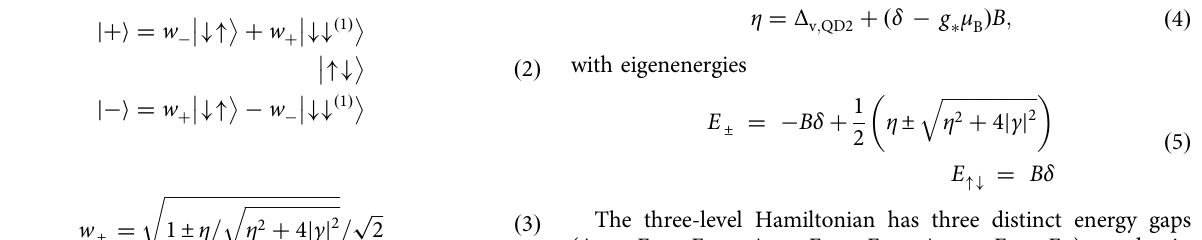
Fig. 2 Spin-valley driven singlet – triplet rotations. a Schematic of the pulse sequence used to interrogate the magnetic fi eld and detuning voltage dependencies of intervalley spin – orbit driven singlet – triplet rotations. The charge occupation of the DQD is labeled (N QD1 ,N QD2 ). b FFT of singlet – triplet rotations at fi xed detuning in (3,1) as the external magnetic fi eld is swept along the [010] crystallographic direction, with superimposed model fi t (red dotted line). The orange dashed line indicates the spin-valley hot spot. We fi t an intervalley SOC strength of 0.132 ± 0.014 μ eV and a valley splitting of 73.177 ± 0.033 μ eV, with uncertainty reported here as 95% con fi dence intervals (see Supplementary Information). c Magnetic fi eld dependence of the system energy levels. Δ v,QD2 is the valley splitting in QD2 and g μ B B is the electronic Zeeman splitting, where g is the electron g-factor, μ B is the Bohr magneton and B is the applied external magnetic fi eld. The orange dashed arrow illustrates the change in the hot spot critical fi eld as the QD-QD detuning is increased. d Singlet – triplet rotations at a fi xed magnetic fi eld of 0.645 T as a function of QD-QD detuning voltage. e Measured singlet – triplet qubit rotation frequency, f , as a function of QD-QD detuning voltage (black circles), with superimposed model fi t (red curve). We estimate a valley splitting lever arm of 46.25 ± 0.85 μ eV/V (see Supplementary Information). f Black circles are extracted inhomogeneous dephasing times, T (cid:3) detuning. The red dashed curve is proportional to ∣ df / dV ∣ − 1 , the expected dependence for quasi-static charge noise, where ∣ df / dV ∣ is found from a numerical derivative of the data in e . g The black circles are the calculated quality factor of qubit rotations ( Q ¼ f ´ T (cid:3) The red dashed curve is the expected quality factor from quasi-static charge noise found from the data in e and the red dashed curve in f three-level system are